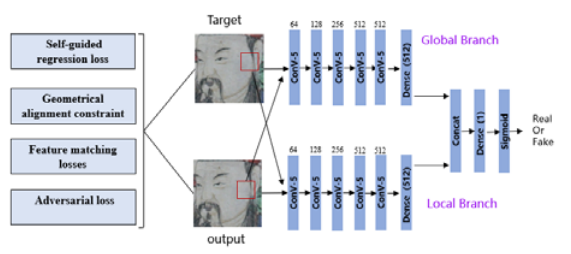
Figure 3 . Discriminative Model